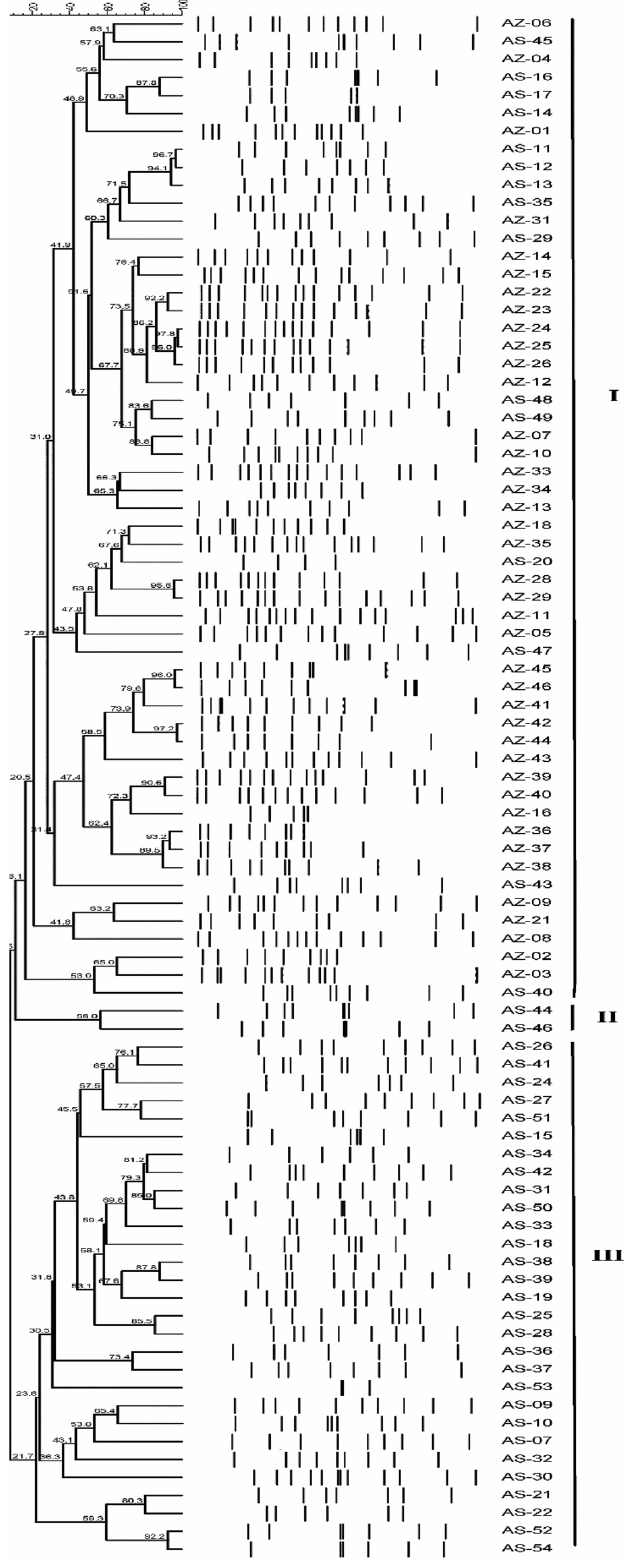
Figure 2. Dendogram clustering for 86 A. baumannii isolates resistant to CIP as determined by ERIC-PCR using UPGMA clustering